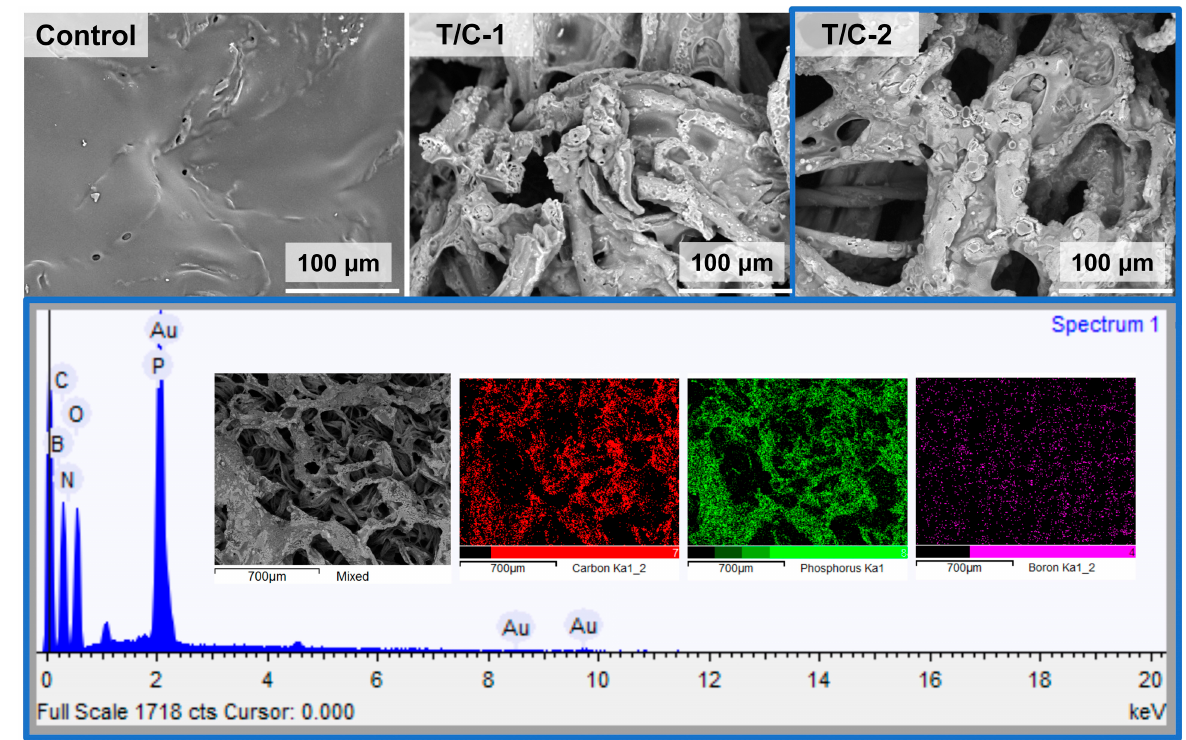
Figure 7. SEM images and EDS mapping of T/C char residues from vertical burning test.